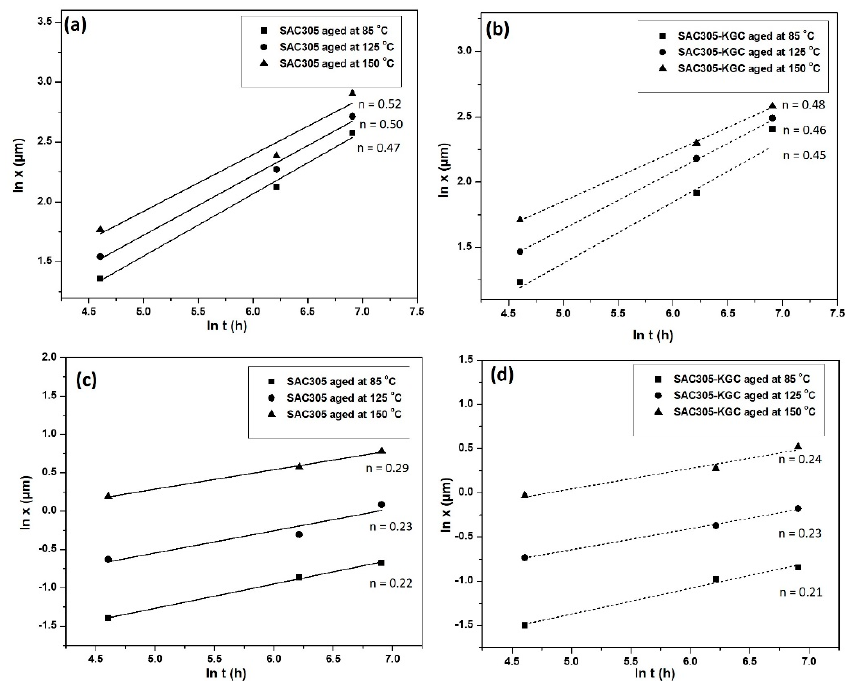
Figure 13. Time exponent of Cu 6 Sn 5 for ( a ) non-reinforced SAC305, ( b ) SAC305-KGC composite solder. Cu 3 Sn, ( c ) non-reinforced SAC305 and ( d ) SAC305-KGC composite